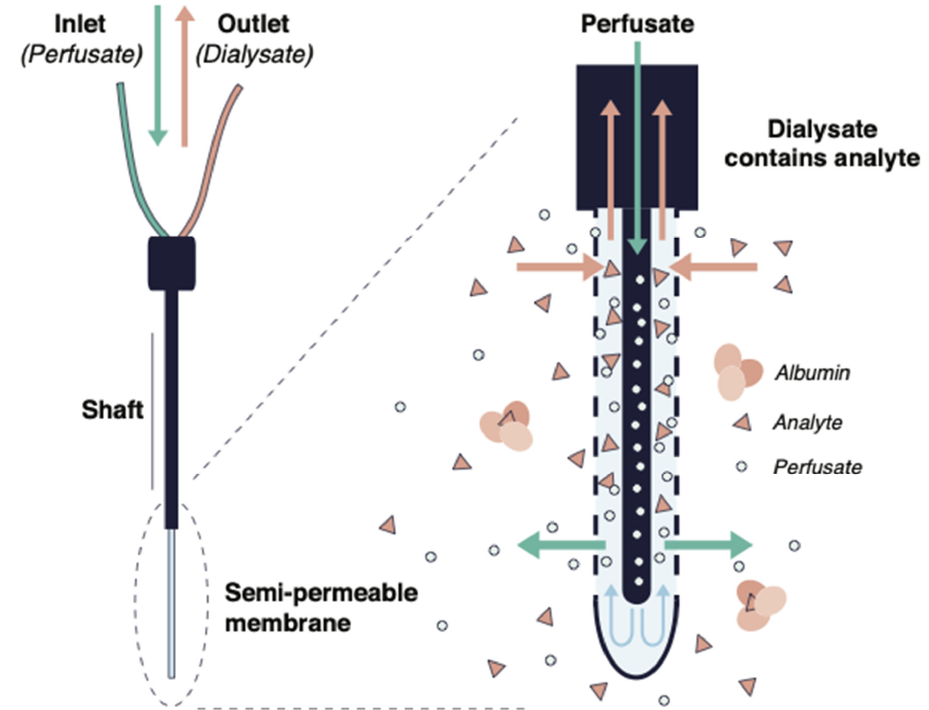
Figure 3. Illustration of the principle of in vitro microdialysis.